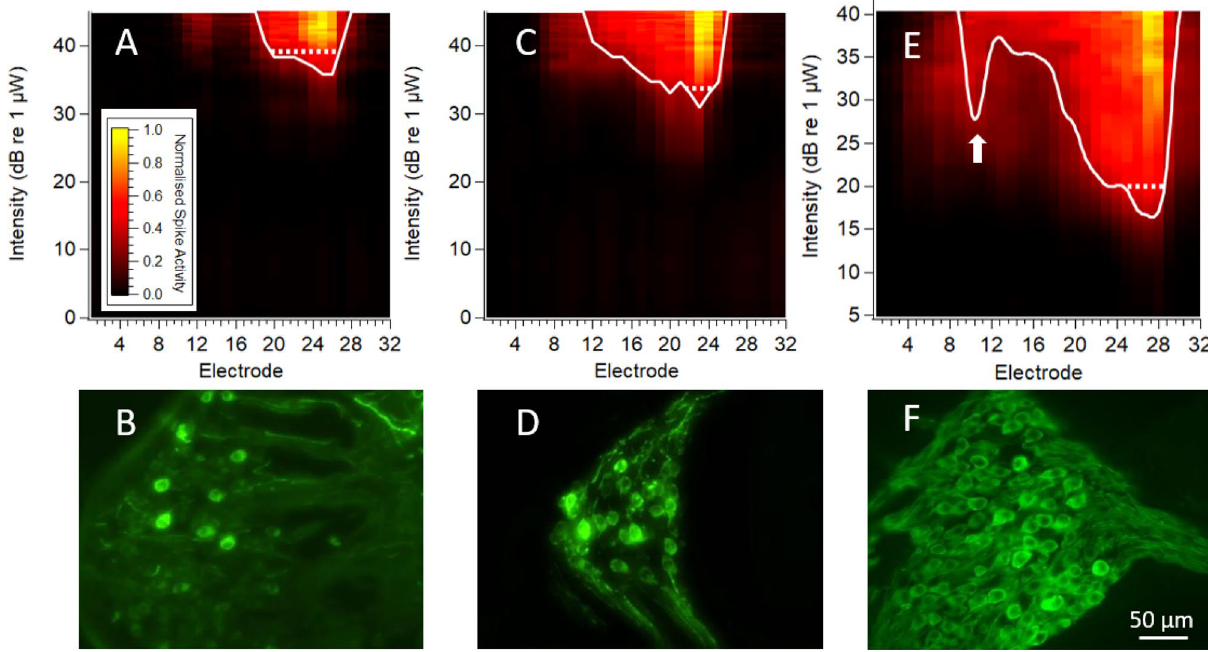
Figure 5. Responses to optical stimulation via a RWM-positioned optical fibre (neonatally AAV-injected C57BL/6 and ChR2-H134R-EYFP transgenic mice) ( A ) Spatial response images showing multi-unit activity at ventral recording sites in response to 1 ms optical stimulation applied via the RWM of the cochlea in a mouse with 6–40% ChR2-H134R-EYFP expression in the basal-mid turn region. ( B ) Image of Rosenthal’s canal from the basal turn of the mouse recorded in (A) showing ChR2-H134R-EYFP expression in occasional SGNs. ( C ) Multi-unit responses to RWM-applied optical stimulation recorded from a mouse with 72–82% of SGNs expressing ChR2-H134R-EYFP in the basal-mid turn region, as shown by the basal turn image of Rosenthal’s canal in ( D ). ( E ) Multi-unit responses to optical stimulation in a ChR2-H134R-EYFP transgenic mouse. A second area of activation at the more dorsal recording sites (arrow) can be observed indicating activation of apical SGNs from an optical fibre positioned in the RWM. This image has been reproduced with permission from 35 . ( F ) Image of the basal turn region Rosenthal’s canal from the ChR2-H134R-EYFP transgenic mouse with expression of in all SGNs. Scale bar in F applies to all histological images. Response images were generated as per Fig. 4. The dotted lines compare the width of activation at an equivalent level above threshold (d’ = 1 above threshold). Minor image processing (brightness, contrast) was applied to images for representation purposes.